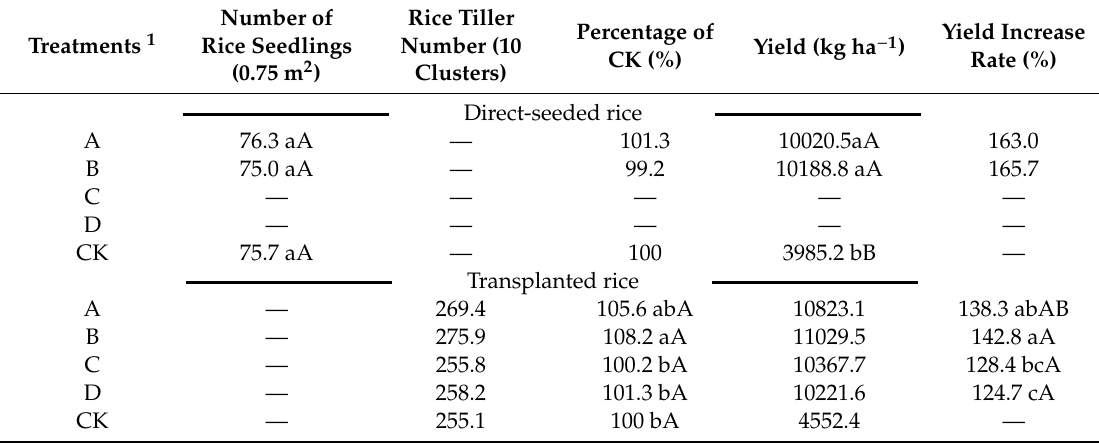
Table 5. E ff ects of various oilseed rape straw mulch treatments and herbicide application on direct-seeded and transplanted rice in field trials.